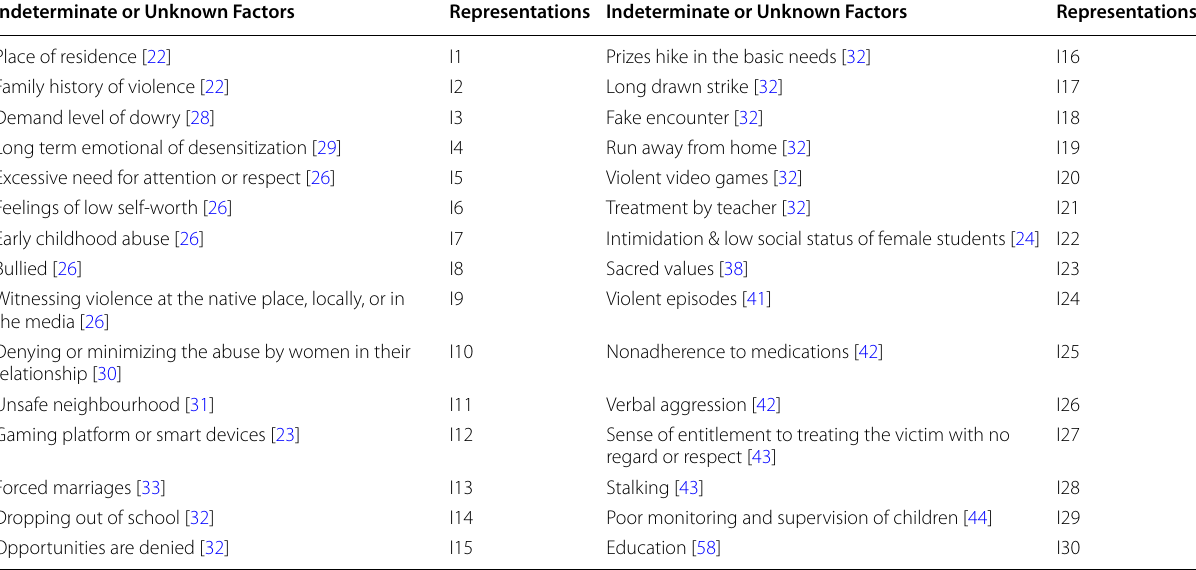
Table 4 Indeterminate or Unknown Factors Indeterminate or Unknown